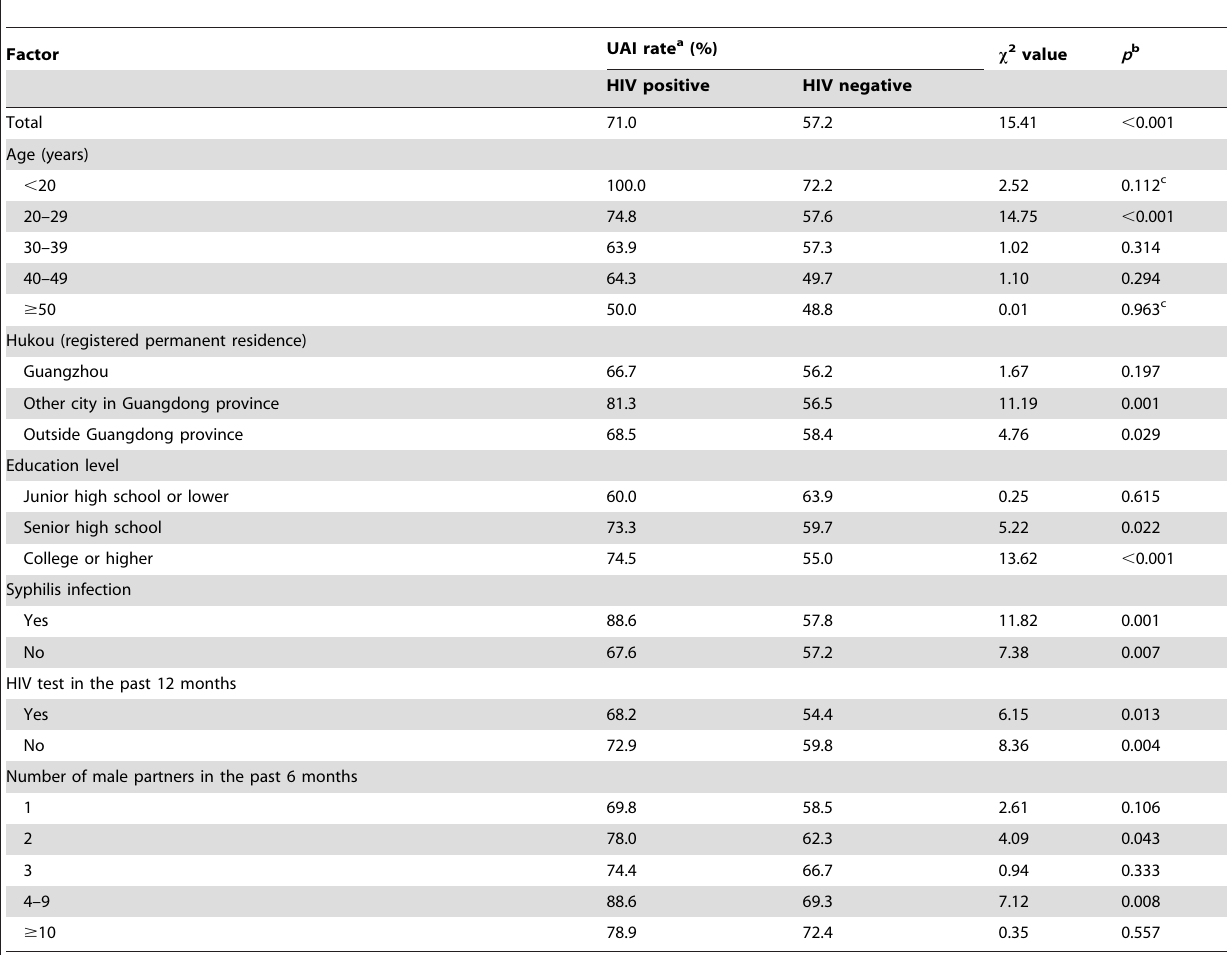
Table 4. UAI rates of HIV-positive and HIV-negative MSM in Guangzhou stratified by the factors associated with HIV infection,